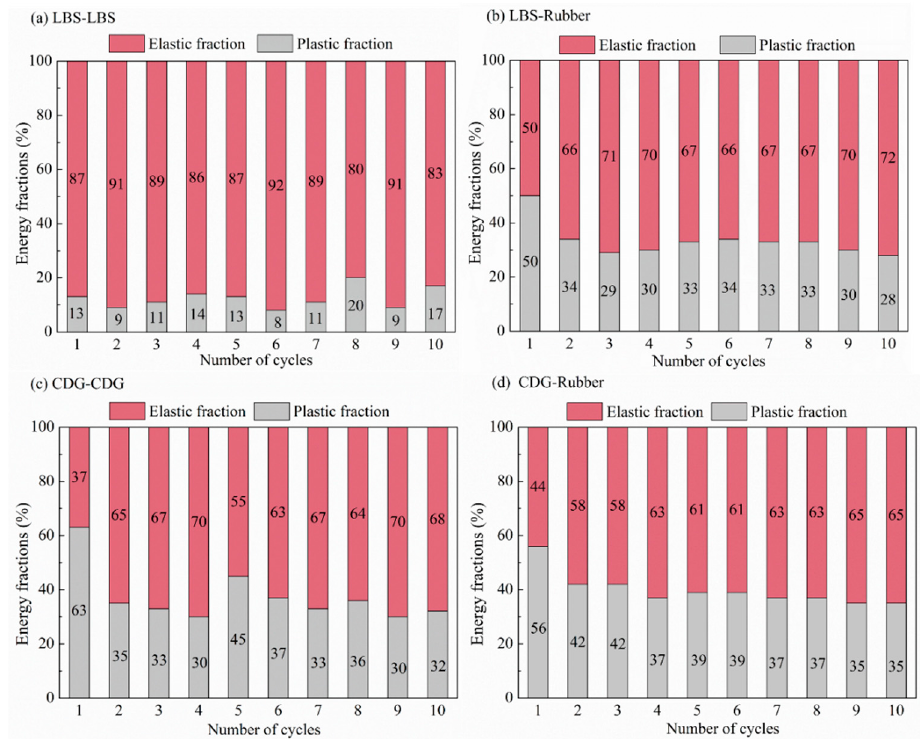
Figure 18. Elastic and plastic fractions of energy input in preloading tests for ( a ) LBS–LBS ( b )CDG–CDG, ( c ) LBS–rubber, ( d ) and CDG–rubber.